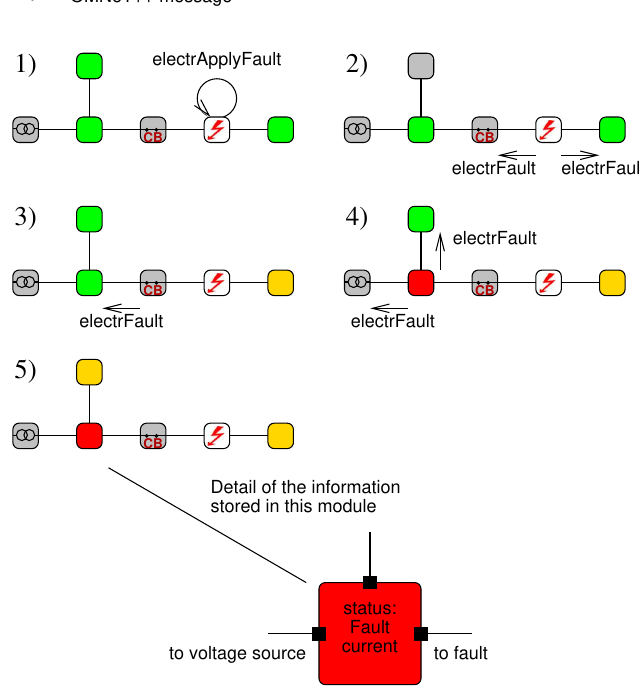
Figure 3. Steps (1)–(5) during the application of a